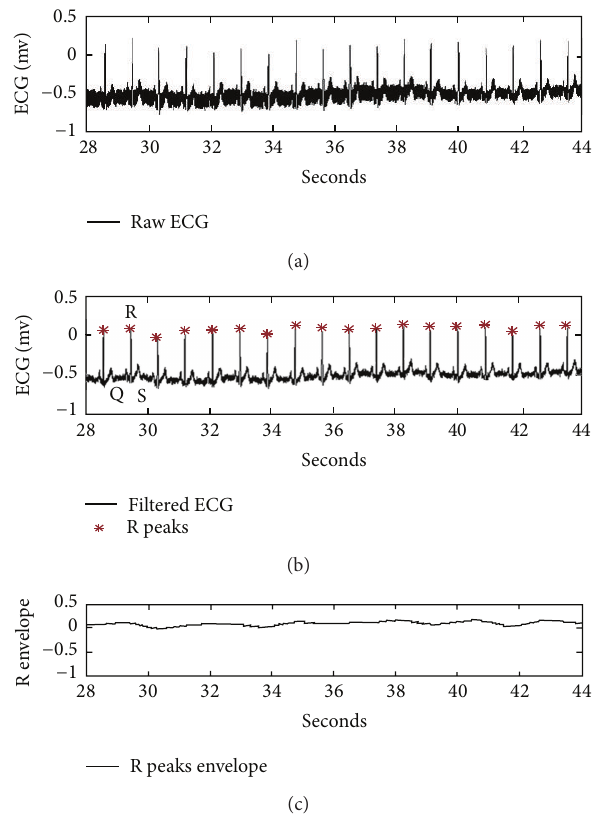
Figure 7: (a) Raw ECG signal corrupted by powerline noise; (b) filtered ECG signal and valid R peaks detected by the processing algorithm; (c) envelope signal of the valid R peaks.